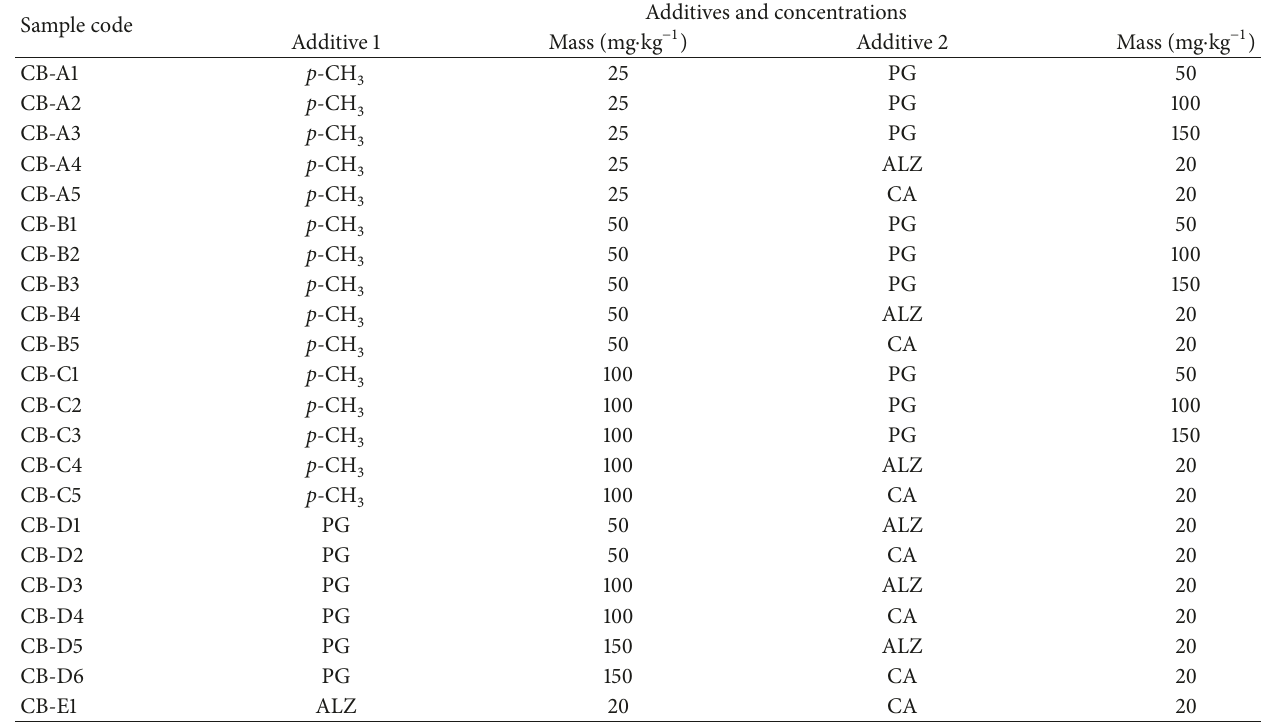
Table 2: Samples doped in binary combinations at different concentrations and the presence of Cu(II).